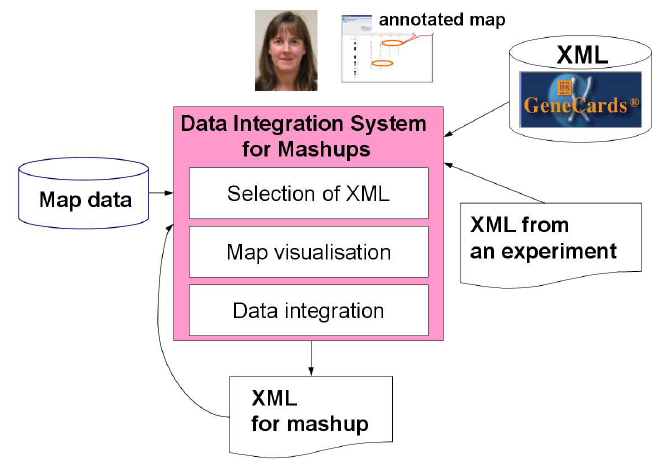
Figure 3: Mashup construction. A biologist interacts with a visualisation which imports map data, and selects XML paths from files or databases. XML data corresponding to the selected paths supports data integration and visualisation. The user then studies an annotated